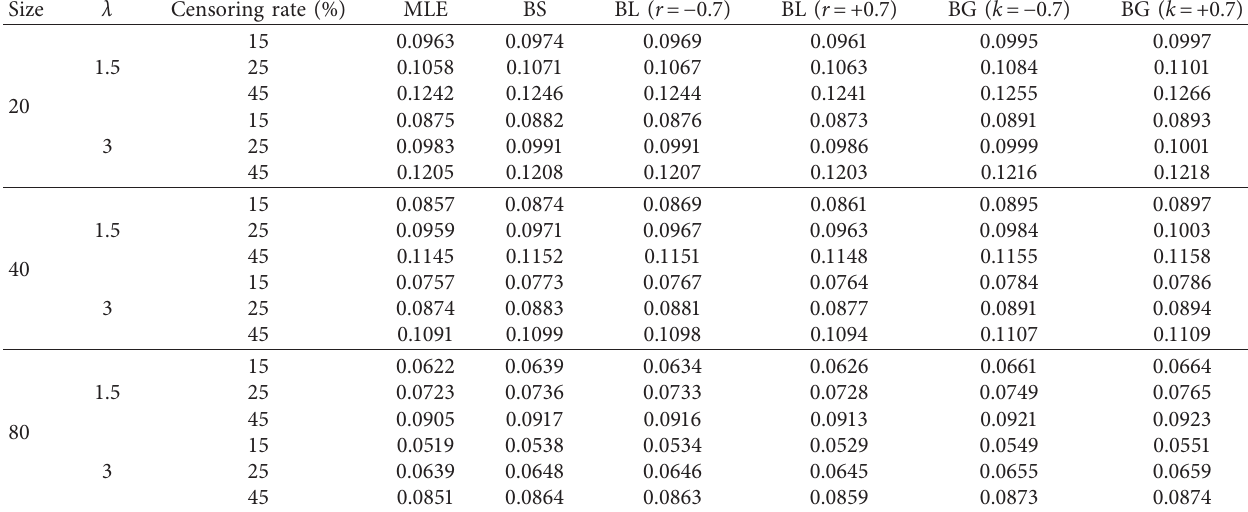
Table 3: MSE estimations of θ with a cure fraction based on the interval-censored data.